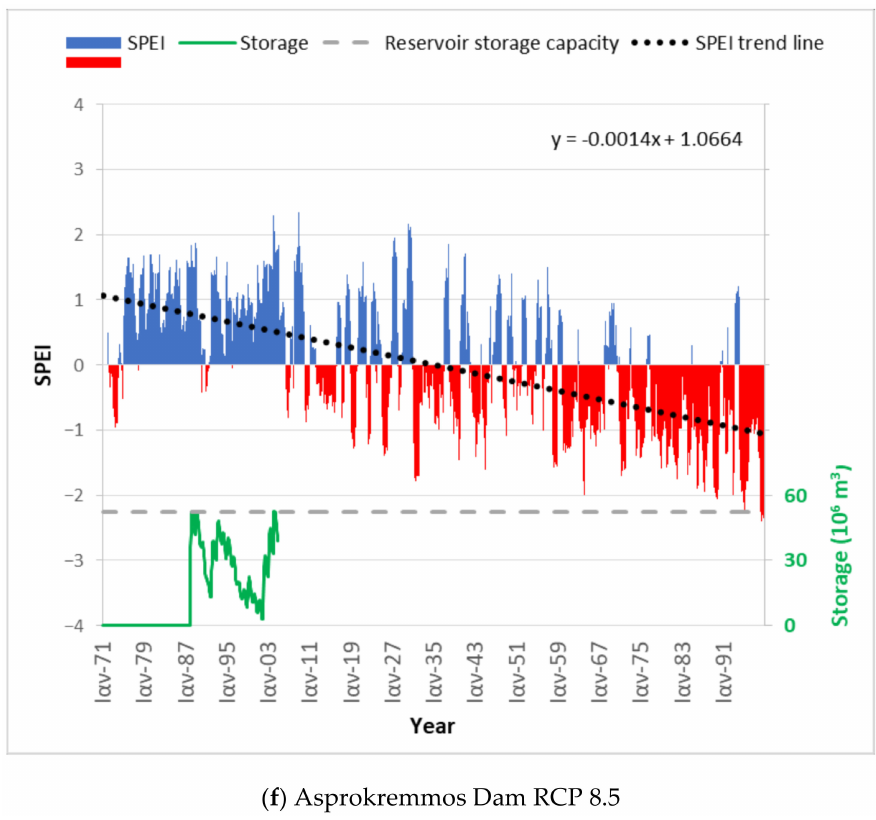
Figure 7. SPEI evolution at locations near the Kiti ( a , b ), Kouris ( c , d ) and Asprokremmos ( e , f ) dam areas under RCP 4.5 and RCP 8.5.